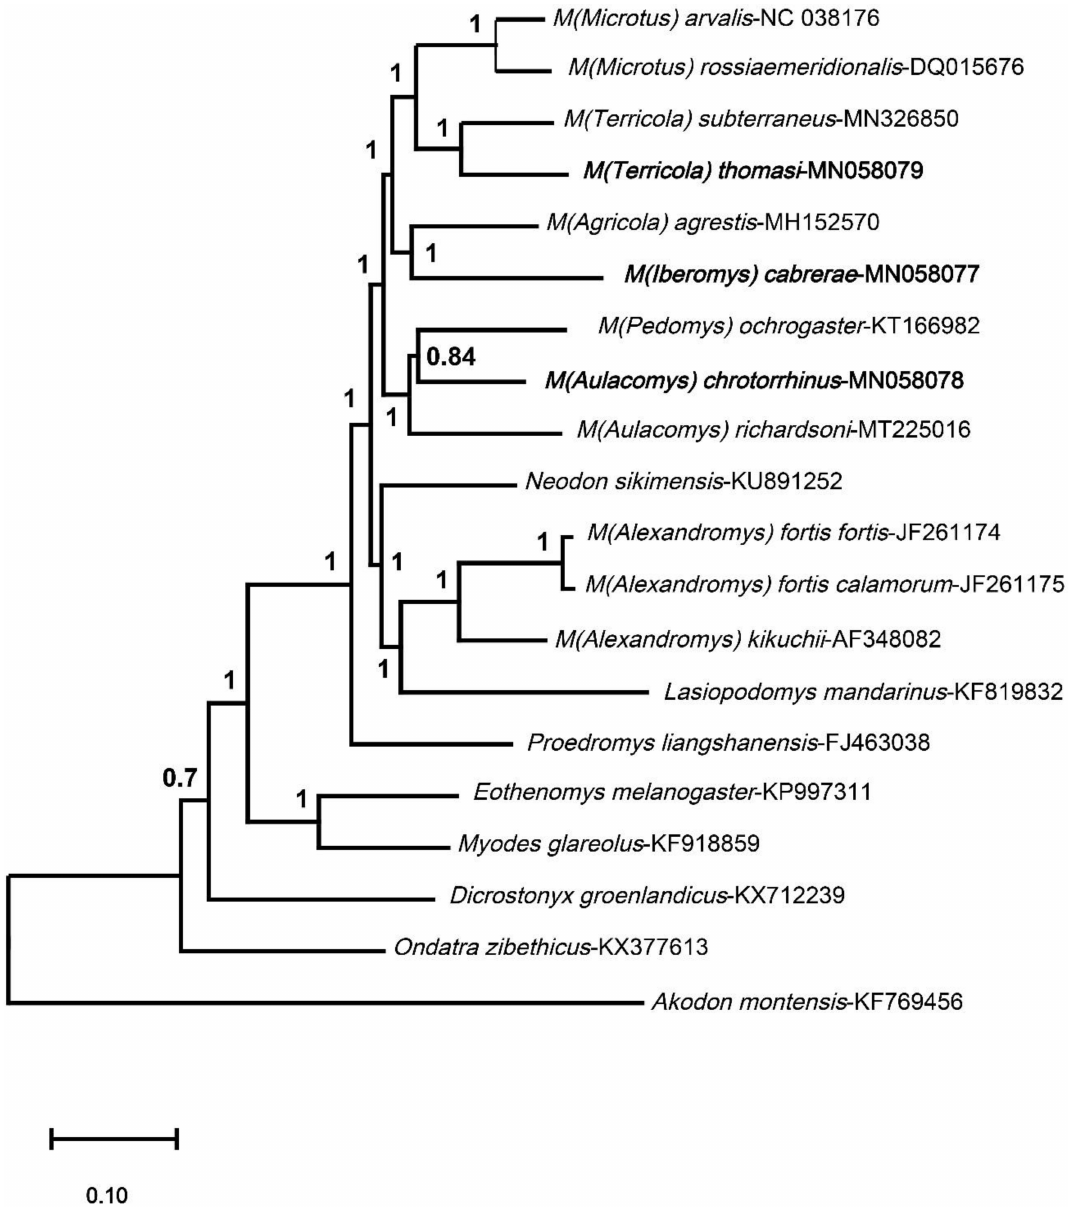
Figure 4. Bayesian Inference tree using the complete mitogenome sequences of ten Microtus species available in GenBank and seven representative species of genera from the subfamily Arvicolinae, and the mitogenome sequence of Akodon montensis (subfamily Sigmodontinae) used as an outgroup. Bayesian posterior probabilities are indicated at each